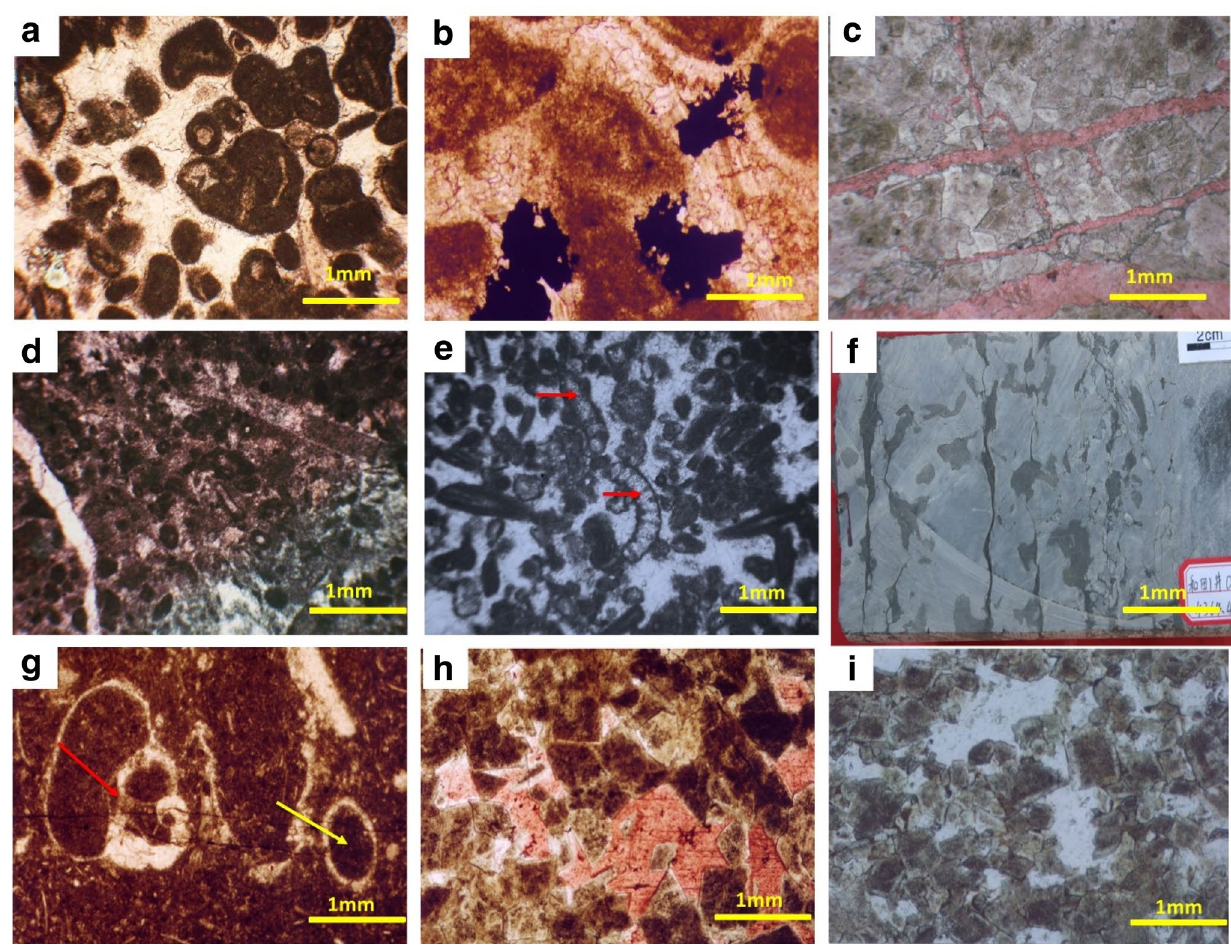
Fig. 7 Photomicrographs of platform reef and shoal microfacies attributes: a bioclastic ooidal–peloidal grainstone (MF-10), under PPL; b ooidal cortoid grainstone: note the large intragranular and grain dissolved vugs isopachous sparry cements and micritic corti- ces fringing the grains (MF-11), under PPL; c photomicrograph of crystalline dolomite, low- to medium-angle regular horizontal frac- ture networks, filled with calcite cement, under PPL; d argillaceous bioclastic peloidal wackestone with micritic intraclasts internal struc-